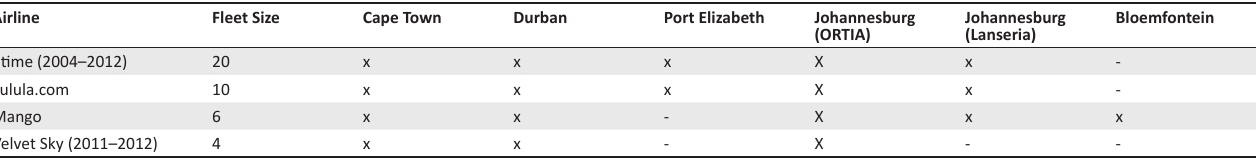
TABLE 1: Low cost carrier domestic destinations.